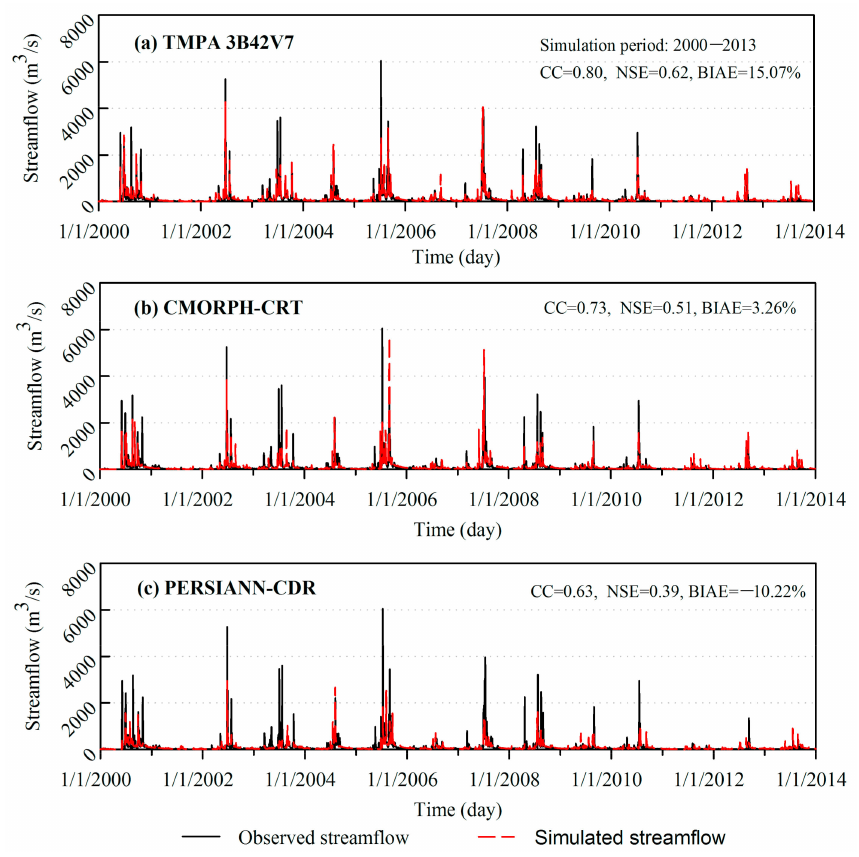
Figure 6. Observed and XAJ model-simulated daily streamflows from the three bias-adjusted SPPs for ( a ) TMPA 3B42V7; ( b ) CMORPH-CRT and ( c )